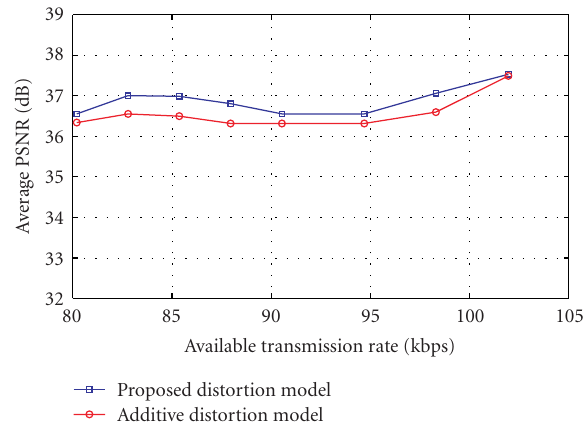
Figure 5: Average PSNR (in dB) as a function of available trans- mission rate (in kbps) for the “greedy-loss distribution” algorithm. Comparison between the proposed and the simplified “additive” distortion model for the video sequence Foreman .